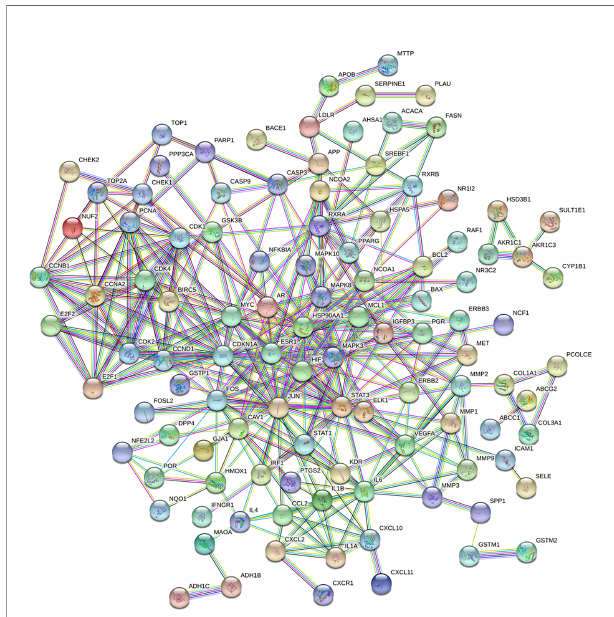
FIGURE 12 | Protein interaction network.